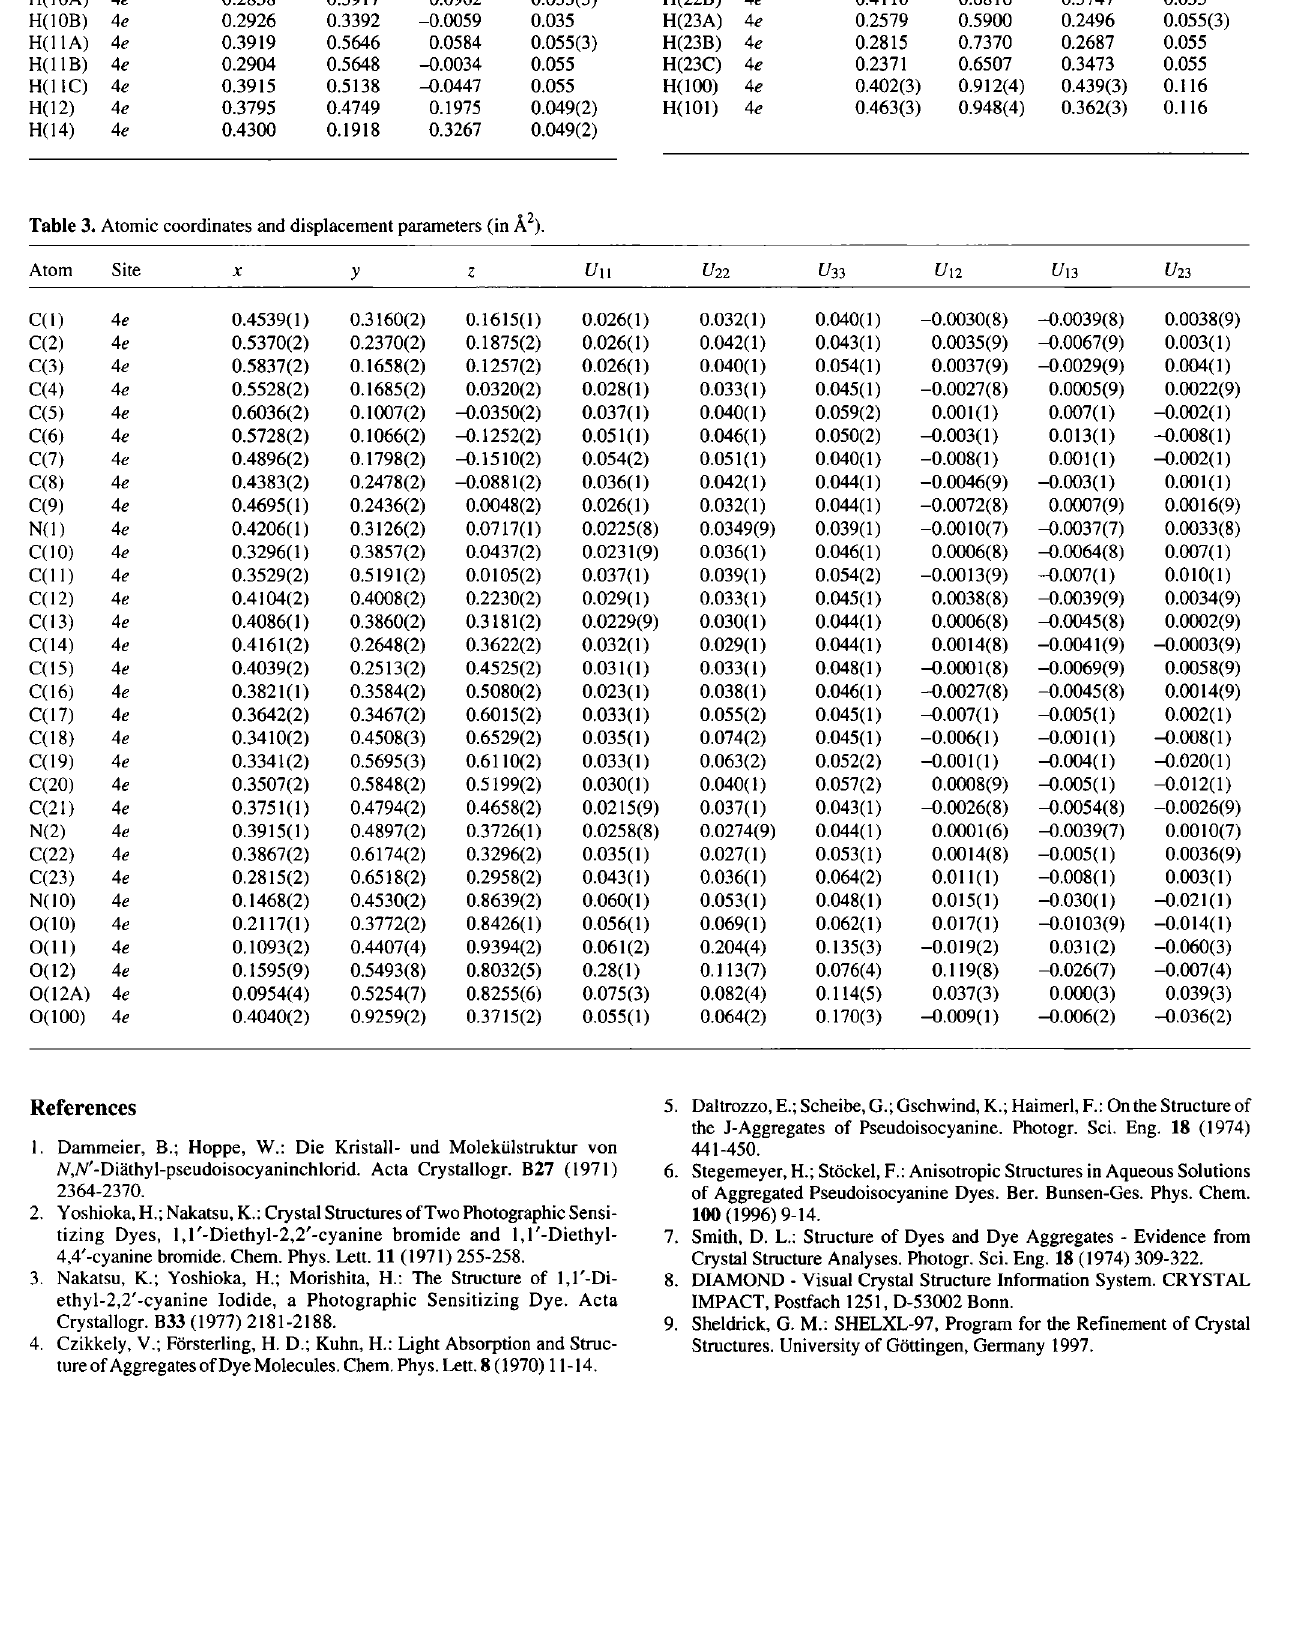
Table 3. Atomic coordinates and displacement parameters (in Ä 2